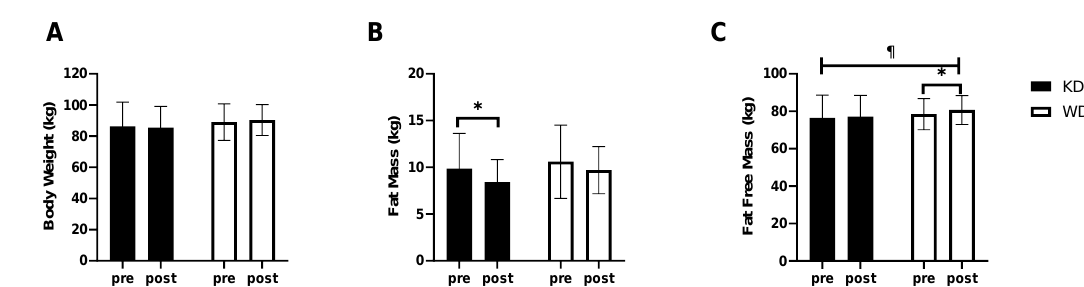
Figure 2. Body composition results after 8 weeks of diet. ( A ) body weight; ( B ) Fat Mass; ( C ) Fat Free Mass. * significantly different from pre-value ( p < 0.05); ¶ time × diet interaction ( p < 0.05). KD, ketogenic diet group; WD, western diet group.